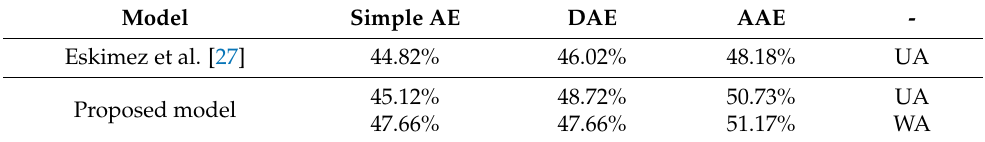
Table 5. Comparison of three autoencoder models in classification with unweighted accuracy